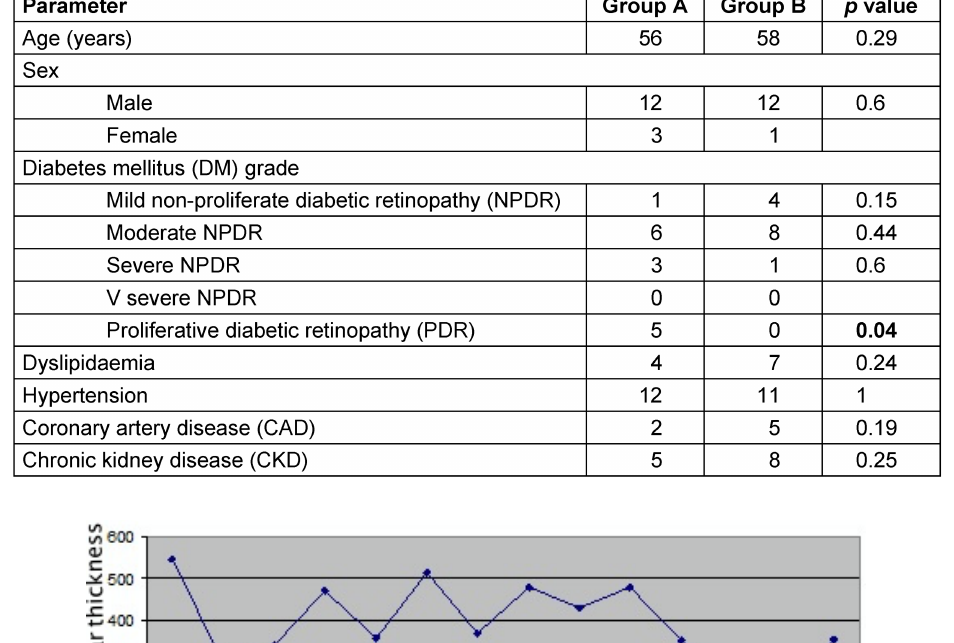
Table 3: Intravitreal dexamethasone implant for refractory diabetic macular edema: comparison of systemic parameters between the two groups at presentation